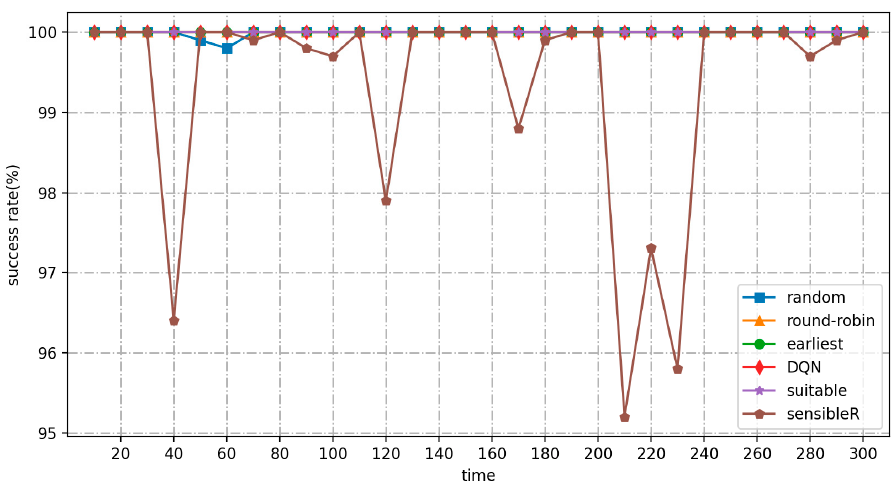
Figure 9. Average response time in low-frequency workload mode.